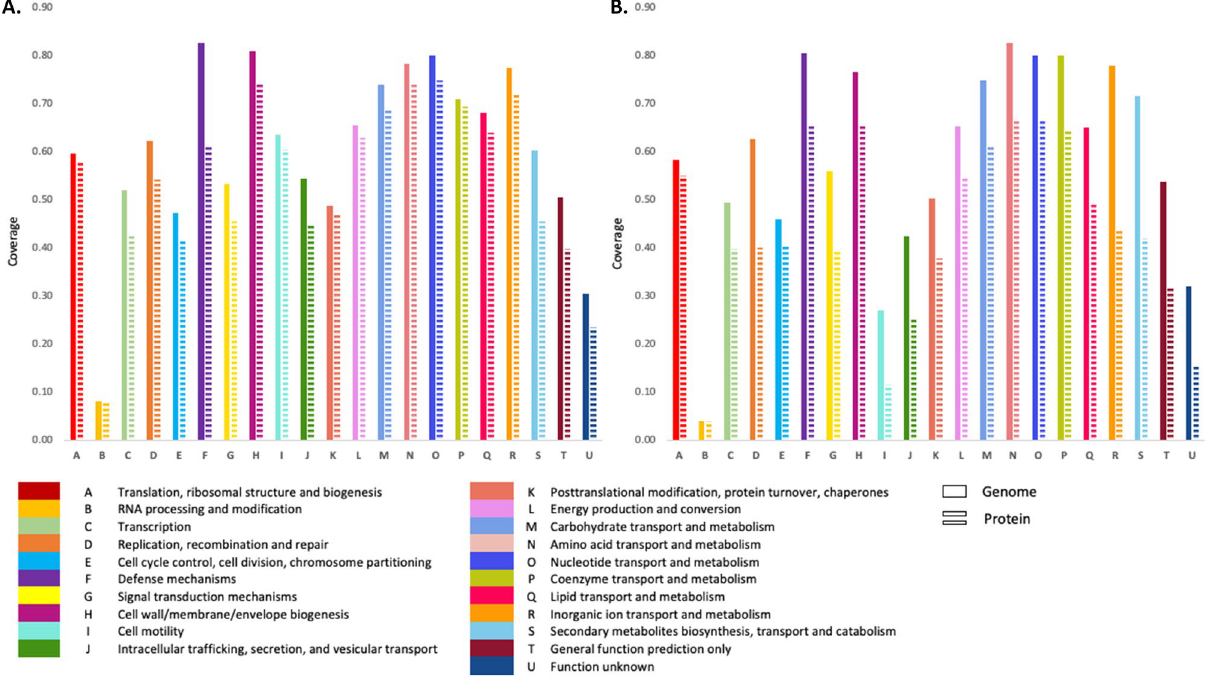
Figure 1. Clusters of orthologous groups (COG) analysis of all genes and all proteins which were detected at least once in the E. coli isolates ( A ) and in the K. pneumoniae isolates ( B ). X-axis: The major functional COG families. Y-axis: The proportion of genes and proteins that were detected in both species compared to the COG database. Genes are represented by solid bars and proteins are represented by interrupted